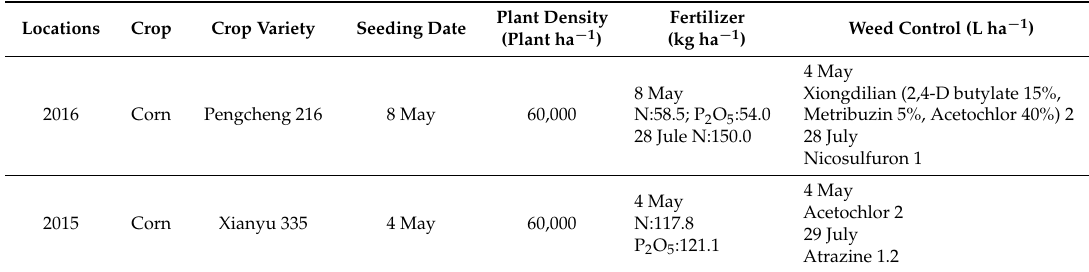
Table 2. Crop management in 2015 and